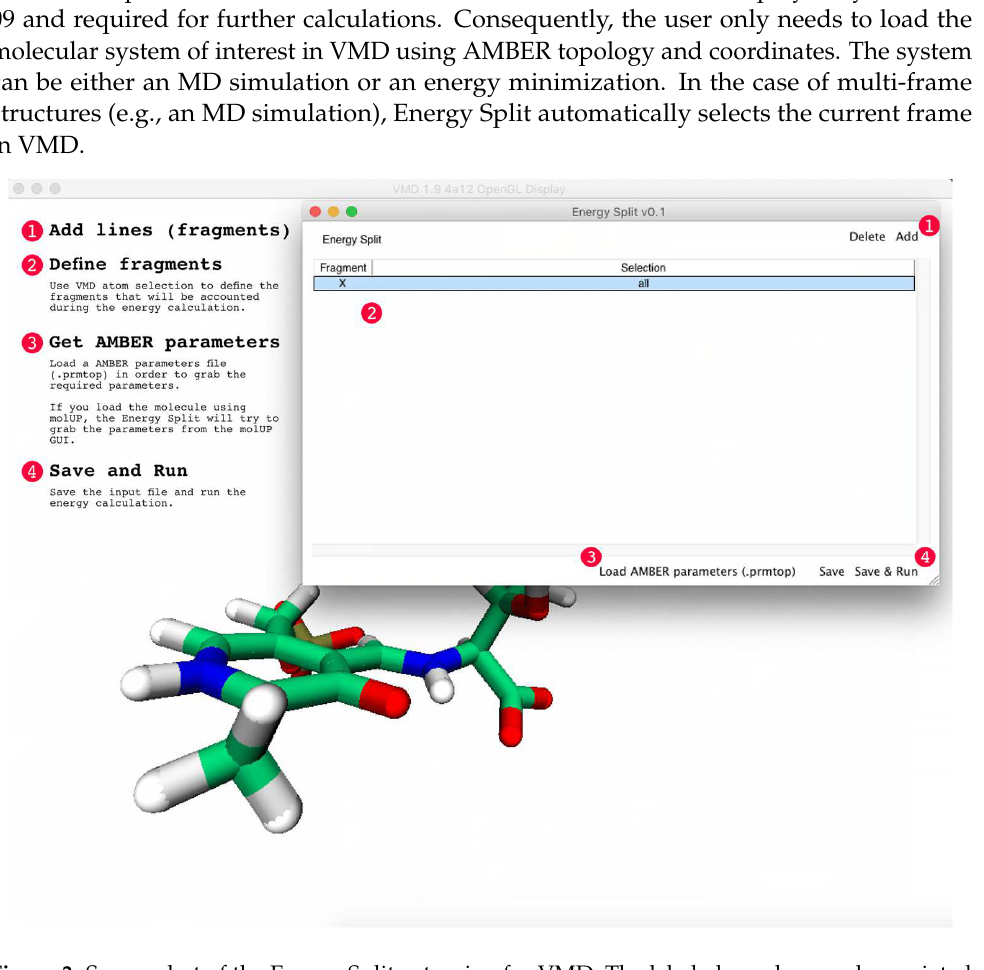
Figure 4. Screen shot of the Energy Split extension for VMD showing a system split into three fragments. For example, if a system has 30 atoms (indexes 0 to 29) and the user chooses two fragments containing indexes 1 to 10 and 15 to 25, respectively, fragment “X” will contain the remaining indexes, namely indexes 0, 11 to 14, and 26 to 29. (Figure 4)